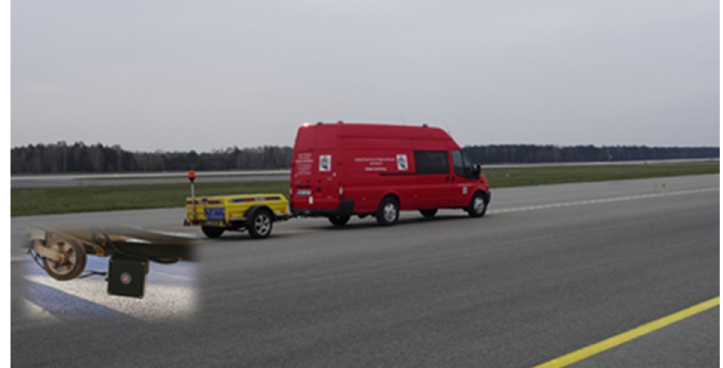
Figure 4. Test with the measurement module.